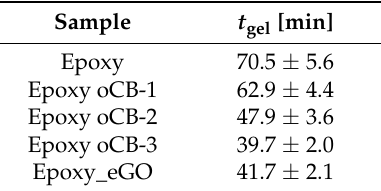
Table 2. Gel time ( t gel ), measured at the intersection of the G ′ and G ″ curves of the neat resin and of the nanocomposites.